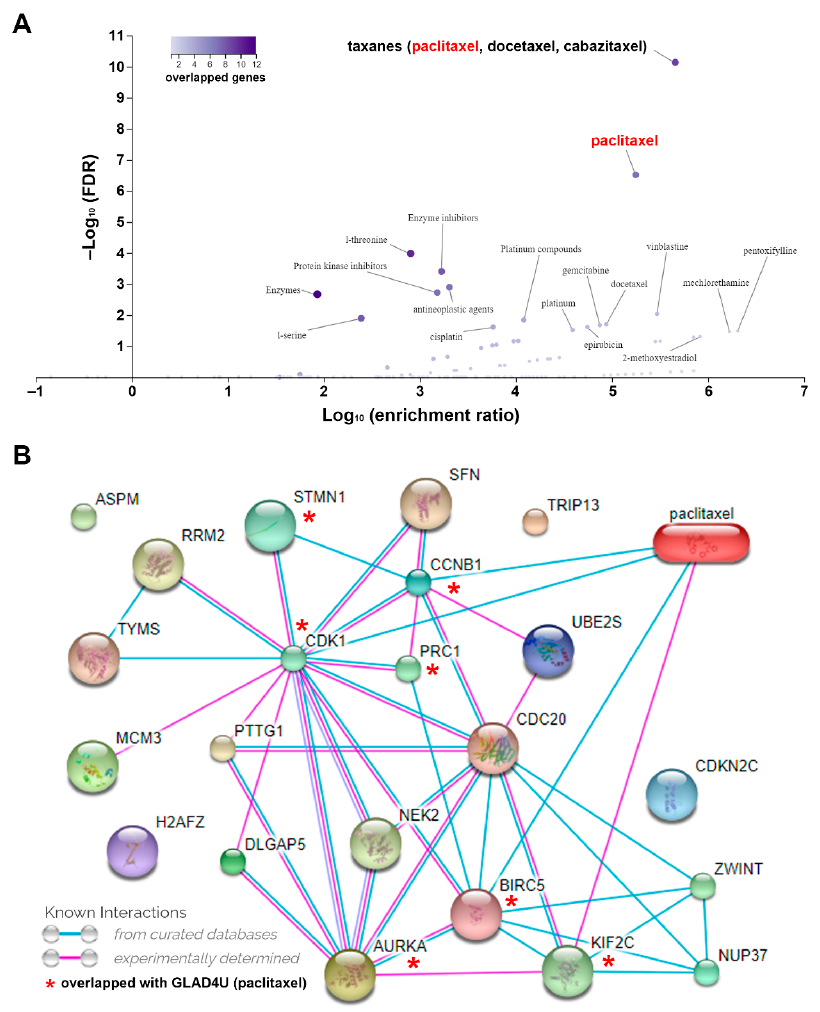
Figure 4. Prediction of potential drugs targeting the mitotic gene signature. ( A ) The association between drugs and mitotic gene signature. ( B ) The network between paclitaxel and mitotic gene signature.